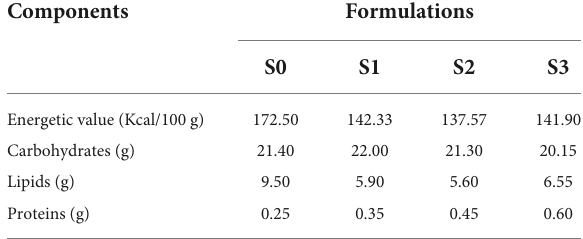
TABLE 3 Nutritional information of sequilhos-type biscuits enriched with different concentrations of macaúba almond flour.